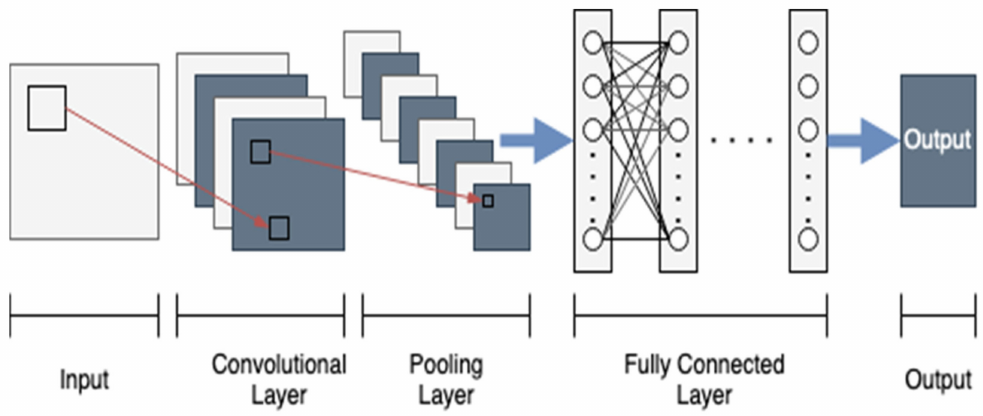
Figure 8. Convolutional neural network CNN